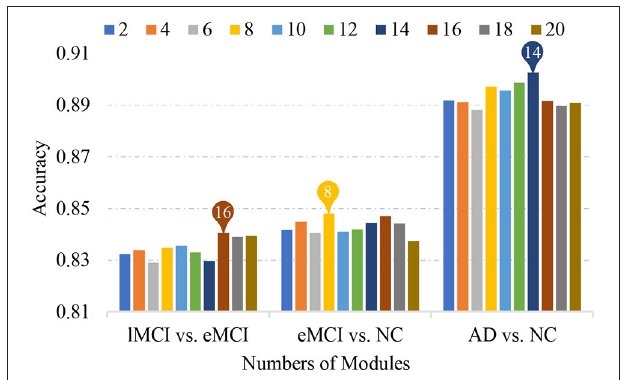
FIGURE 7 | Classification accuracy achieved by the proposed method using different numbers of modules in three classification tasks.